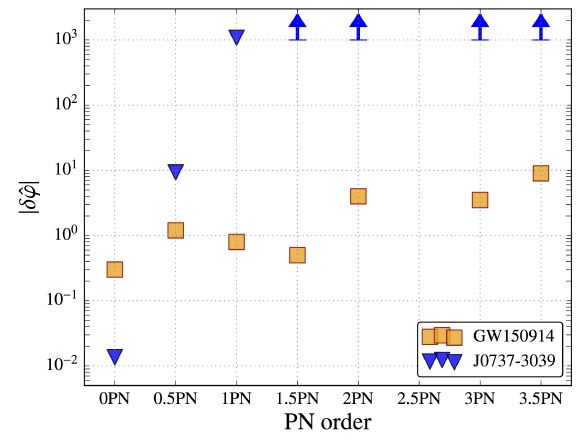
Figure 8. Upper bounds (denoted by | δ ˆ φ | ) on the fractional deviations of the post-Newtonian coefficients from their general relativistic prediction are plotted against the PN orders for the gravitational wave observation as well for binary pulsar observation. Binary pulsar puts better constraints at the leading order, while bounds are much better at the higher orders for gravitational wave observation. (Image credit: